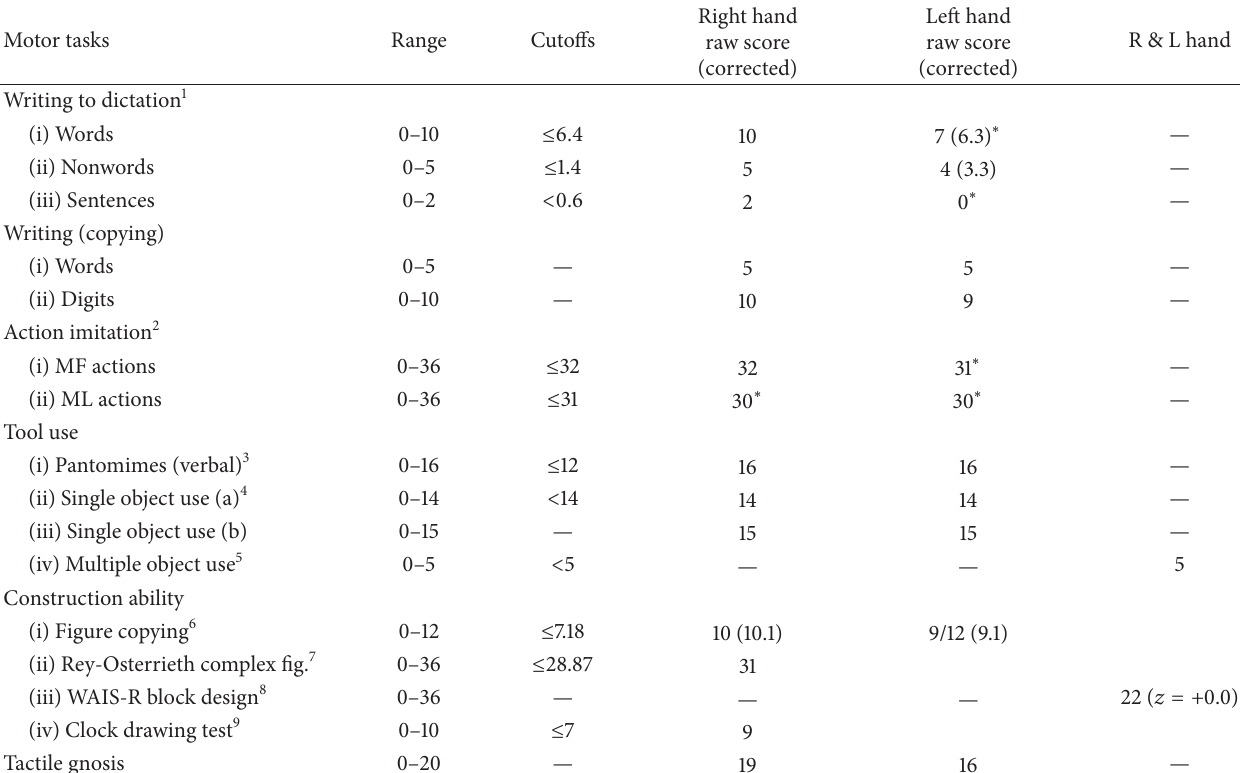
Table 2: DA performance on selected motor tasks (the star indicates scores below cutoffs).